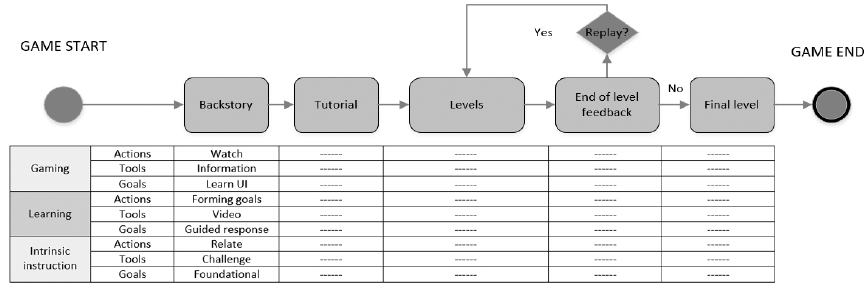
Fig. 2. Generic game sequence